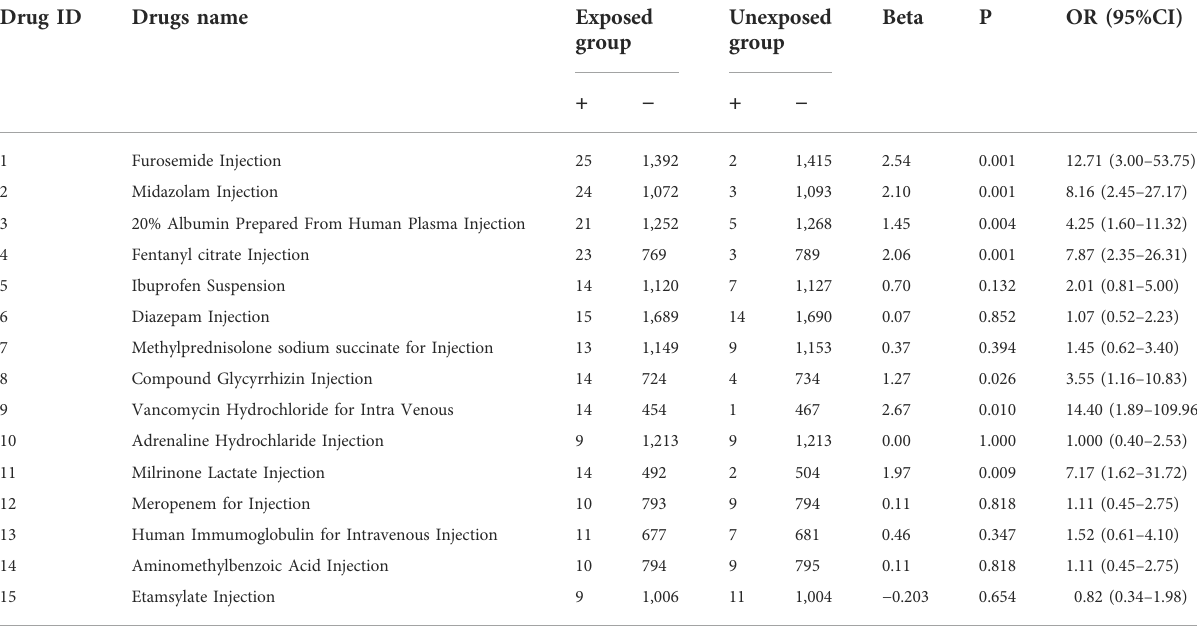
TABLE 2 Exposure and non-exposure of suspected drugs and the risk of DIKI.